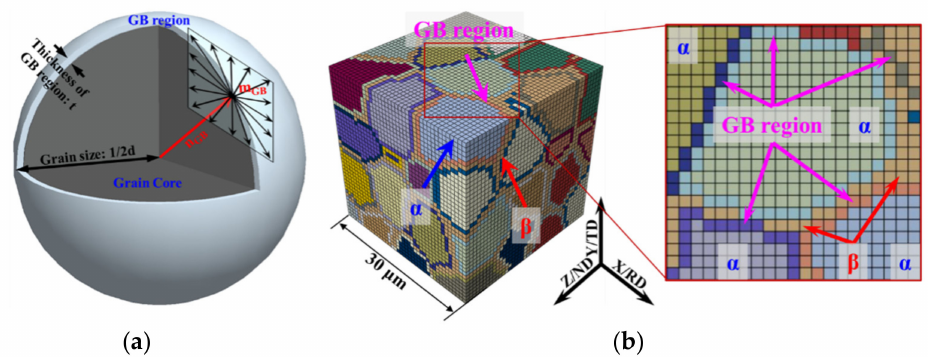
Figure 3. Schematic diagram of motion systems of GB dislocations and the polycrystalline model with the GB region of TA15 samples. ( a ) Motion systems of GB dislocations; ( b ) polycrystalline model with the GB region and the partial enlarged